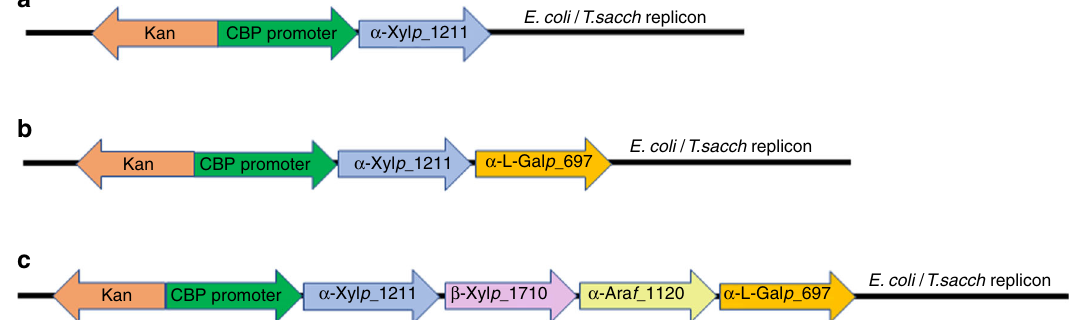
Fig. 4 Expression constructs for glycosyl hydrolase expression in T. thermosaccharolyticum . a Construct for single enzyme expression, b construct for two genes which paired α -Xyl p _1211 with another enzyme, and c construct for expression of four genes together; three such constructs, as shown in Supplementary Table 11, were bulit. CBP promoter: strong promoter from C. thermocellum that drives the cbp (Clo1313_1954) gene; Kan: Kanamycin resistance marker; E. coli/T. sacch replicon: contains origins of replication for E. coli and T. thermosaccharolyticum / T. saccharolyticum